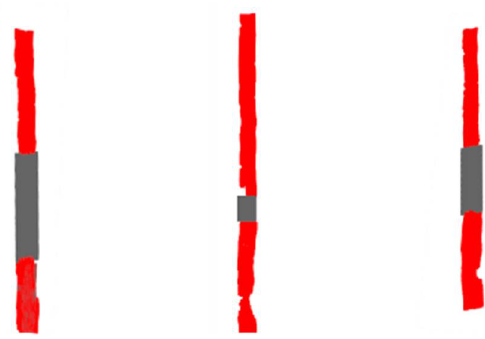
Figure 14. The point cloud filling results.